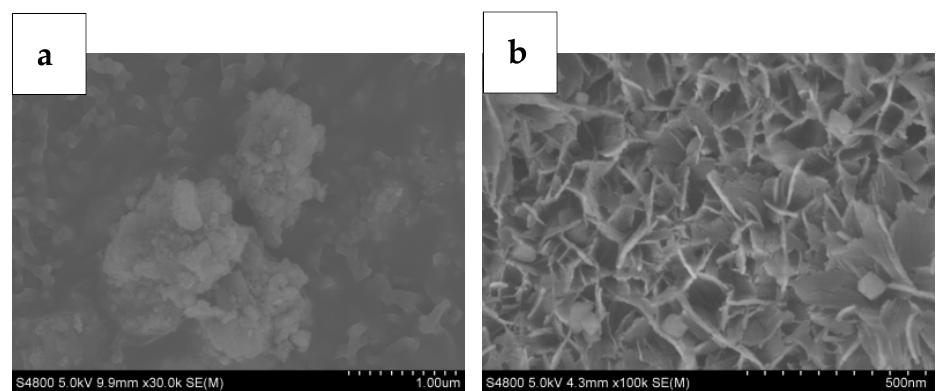
Figure 2. SEM images of fresh AA ( a ) and MnOOH-supported AA ( b